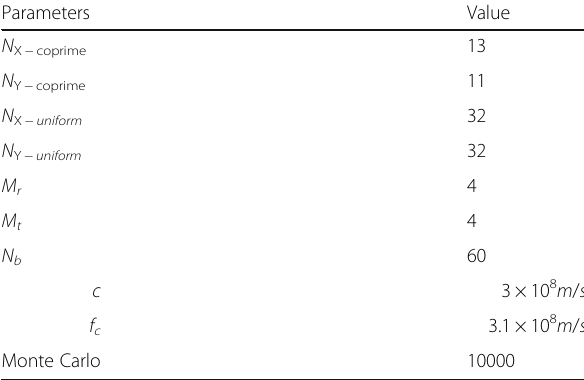
Table 1 Simulation parameters